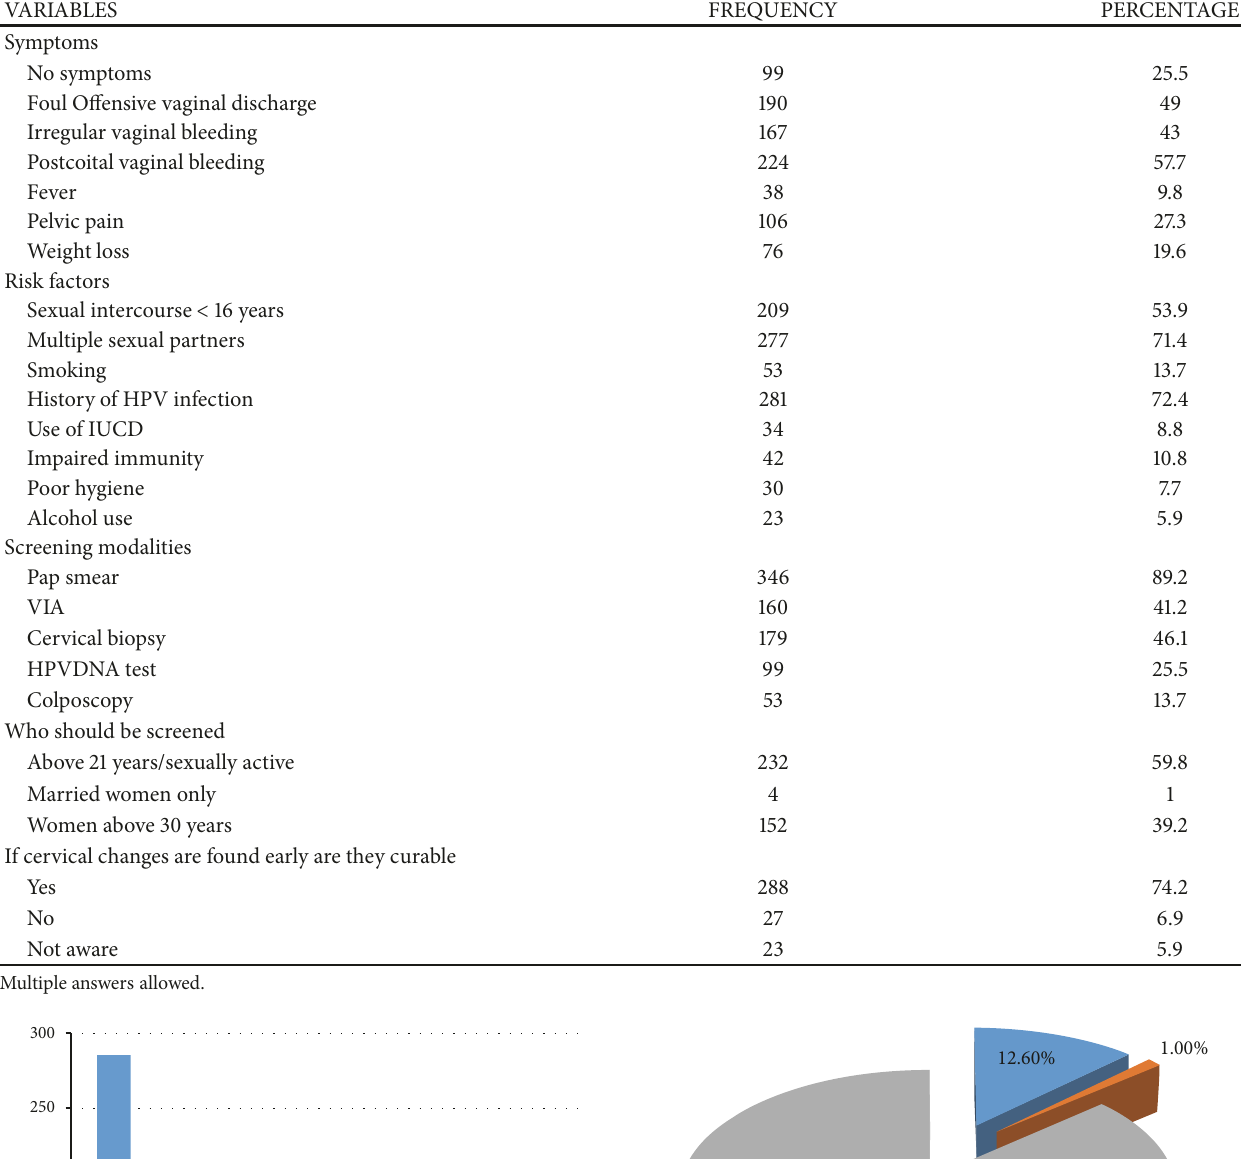
Table 2: Knowledge of cervical cancer and screening.